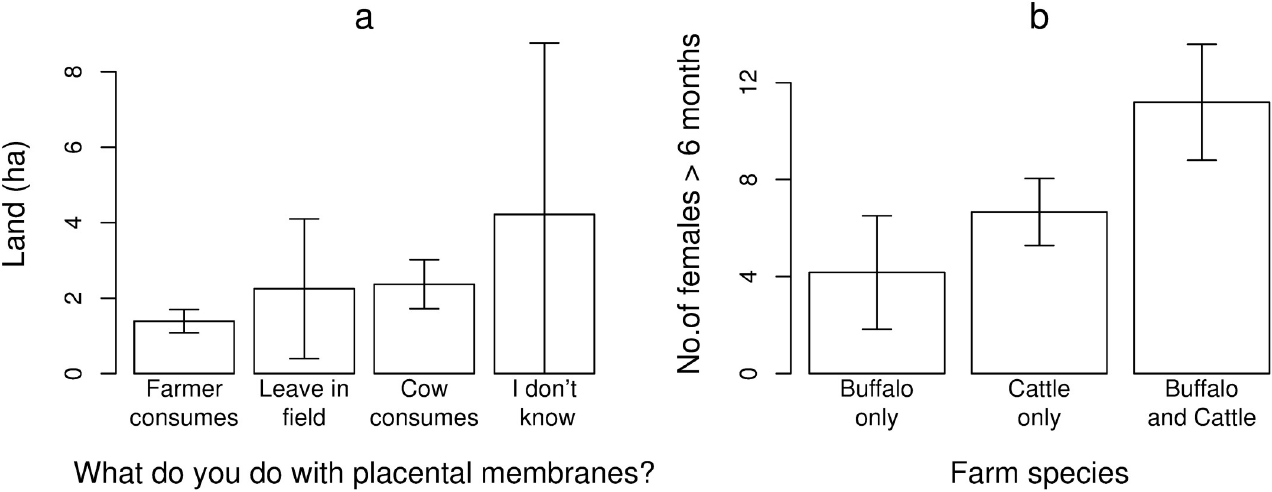
Fig 1. Bar charts conveying trends on smallholder farms in 2018, Lao PDR. (a) The average land size associated with the different disposal methods of large ruminant placental membranes (b) The average number of female large ruminants > 6 months of age associated with farm species. Error bars shown are ± SE.